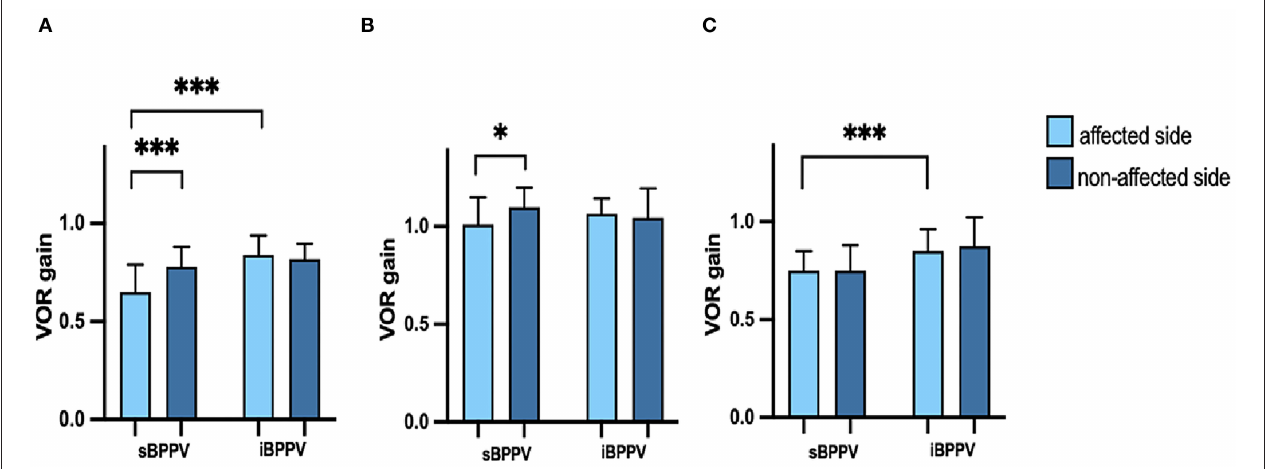
FIGURE 1 | (A) Vestibular-ocular reflex (VOR) gains of the posterior semicircular canal (SCC) in patients with secondary benign paroxysmal positional vertigo (s-BPPV) and idiopathic BPPV (i-BPPV); (B) VOR gains of horizontal SCC in patients with s-BPPV and i-BPPV; (C) VOR gains of the anterior SCC in patients with s-BPPV and i-BPPV. An upper end of the box is the median. The whisker is the interquartile range (IQR). * p < 0.05; *** p < 0.001.